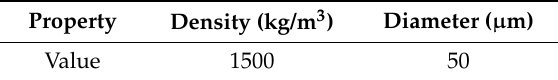
Table 2. Properties of the